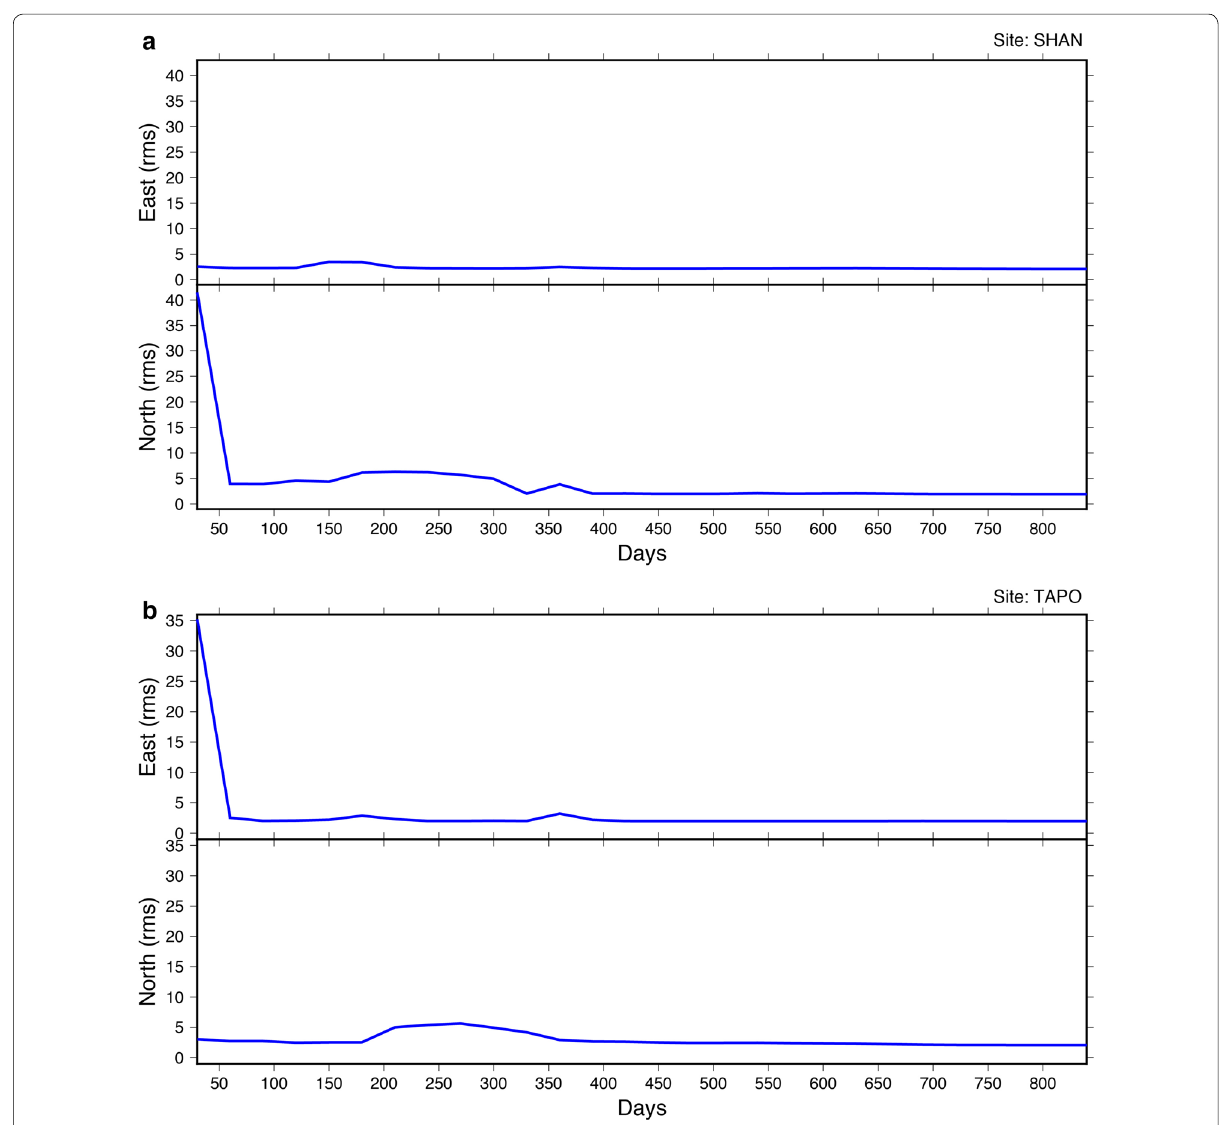
Fig. 3 RMS residuals between GPS data and predict data derived from fitting curves for every 30 days at stations a SHAN and b